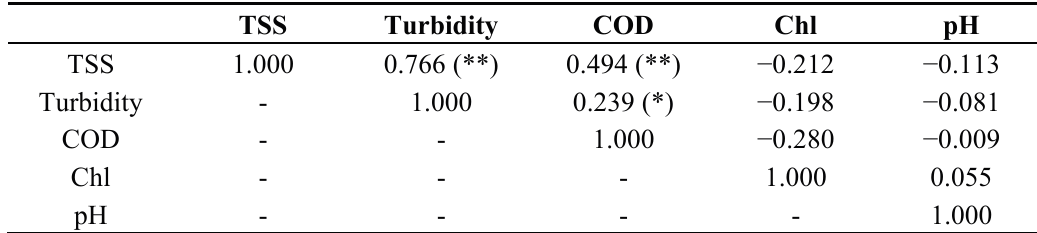
Table 2. Pearson c orrelation matrix of water quality parameters.